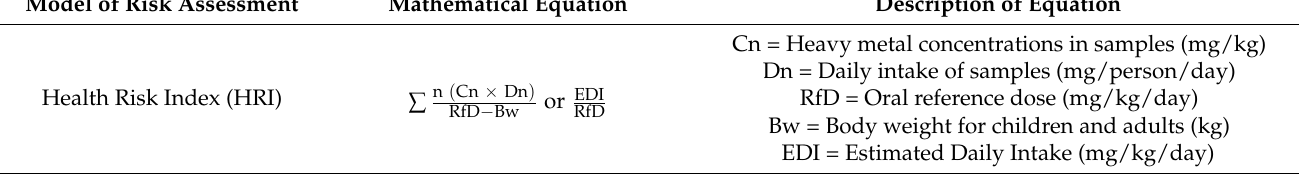
Table 4. Mathematical models for risk assessment on heavy metal exposure. Adapted from EPA [147]. Model of Risk